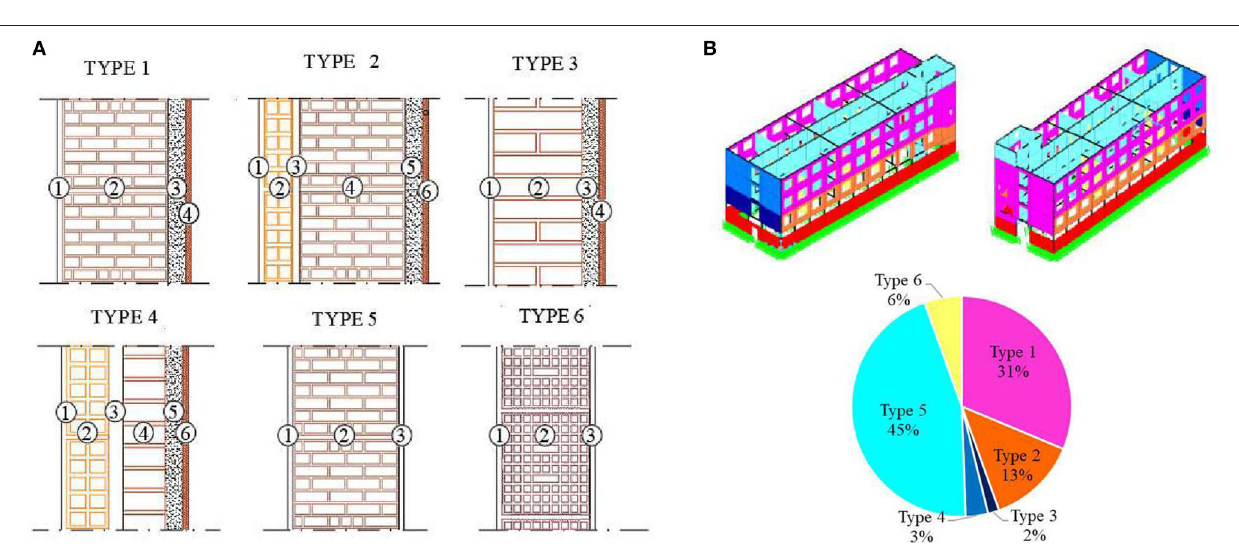
solid block infill walls (Type 3). It is worth to note that all the typologies of infill walls detected in the building are characterized by horizontal mortar joints of ∼ 1–1.5 cm thickness, while the vertical layers are offset. The hollow clay bricks are arranged with horizontal holes, and they are characterized by a void percentage approximately of 55%. A sketch of the different infill walls and partition typology is presented in Figure 4 together with their percentage in the building. A detailed description of the stratigraphy of the thickness is reported in Table 1